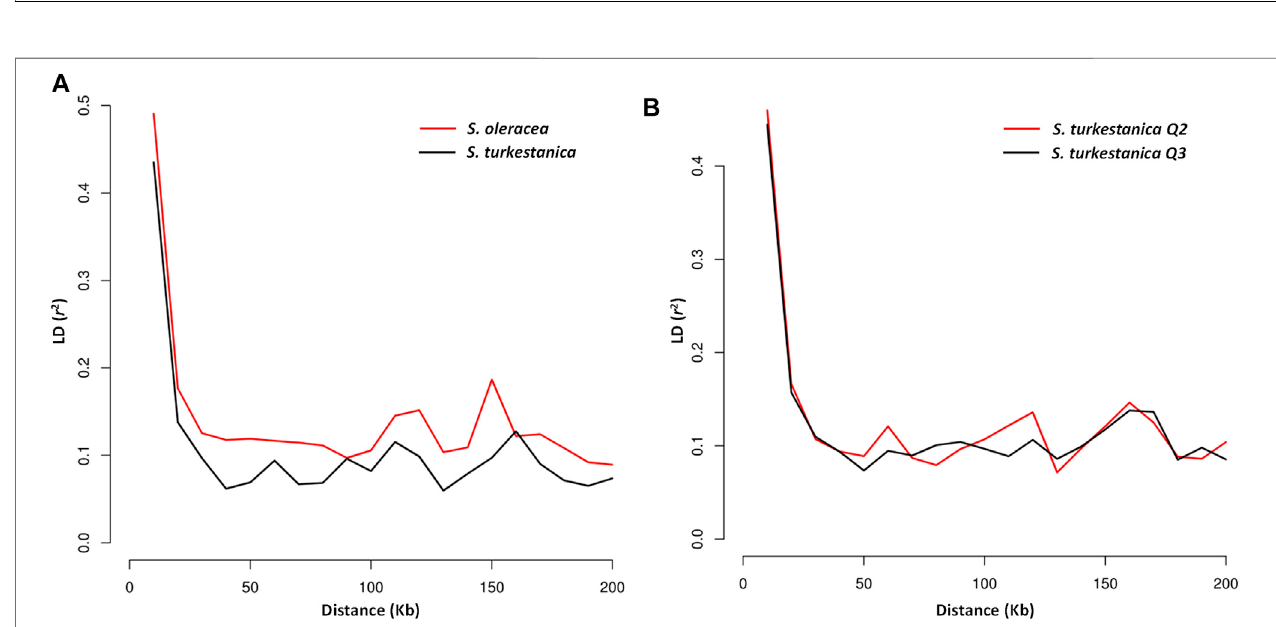
FIGURE 5 | Linkage disequilibrium (LD) decay determined by squared correlations of allele frequency ( r 2 ) against physical distance (Kb) between single nucleotide polymorphismmarkersof (A) accessionsofcultivatedspinach, Spinaciaoleracea ,vs.accessionsofthewildrelative, S.turkestanica ;and (B) group Q 2vs. Q 3of S.turkestanica .